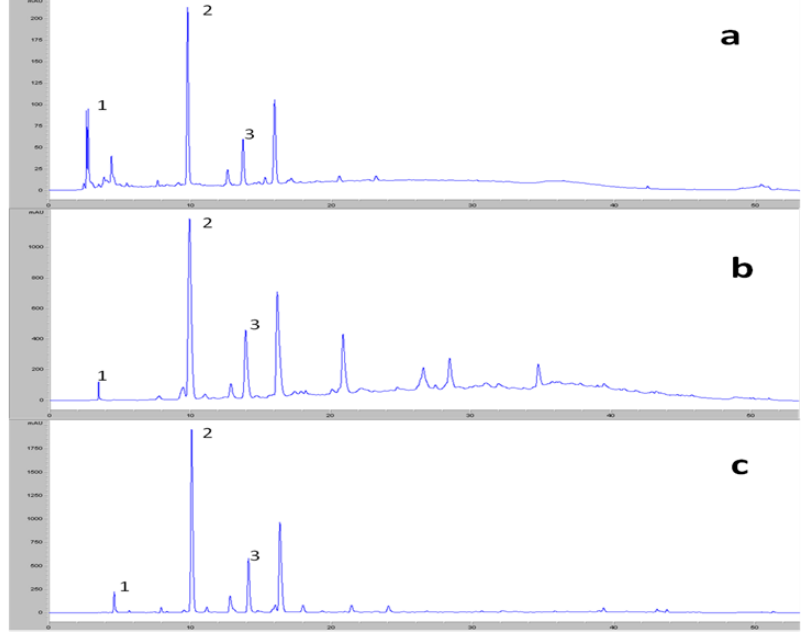
Figure 2. Profiles obtained by HPLC at 280 nm for a sample of alperujo water ( a ), the phenolic extract obtained with resin ( b ) and the phenolic extract obtained with ethyl acetate ( c ), identifying DHPG (1), hydroxytyrosol (2) and tyrosol (3).